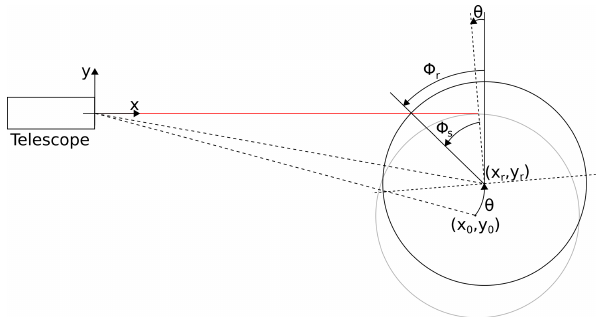
Figure 3. Instead of tilting the beam, the centre of the wheel is rotated around the lens centre.